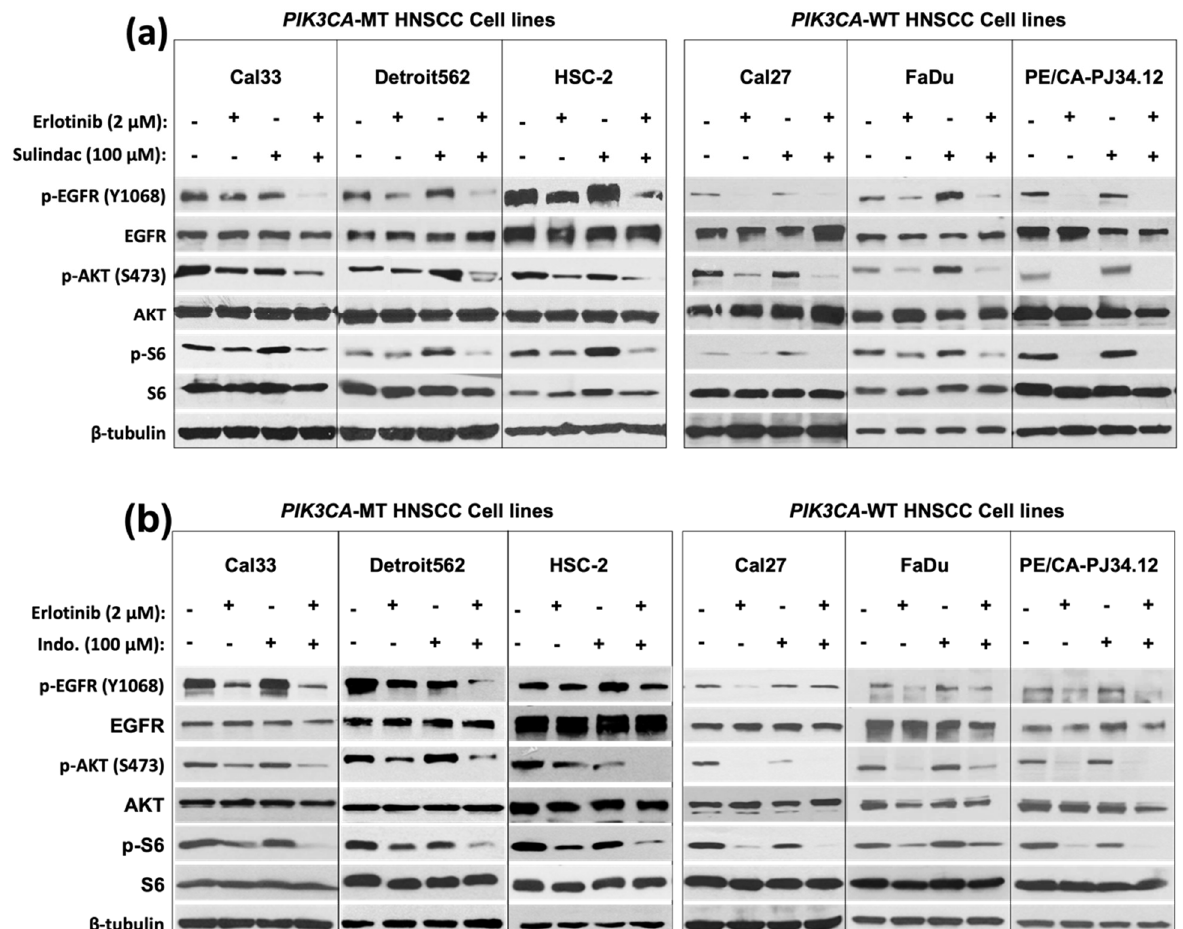
Figure 3. Combination of NSAIDs with EGFR TKI abrogates downstream signaling. HNSCC cell lines with WT PIK3CA (Cal27, FaDu, and PE/CA-PJ34.12) or PIK3CA mutation (H1047R; Cal33, Detroit562, and HSC-2) were treated with vehicle, sulindac (100 µ M), indomethacin (100 µ M), erlotinib (2 µ M), or a combination of sulindac and erlotinib ( a ), or indomethacin and erlotinib ( b ), for 24 h followed by collection of whole cell lysate and immunoblot analysis. The uncropped Western blots have been shown in Figure